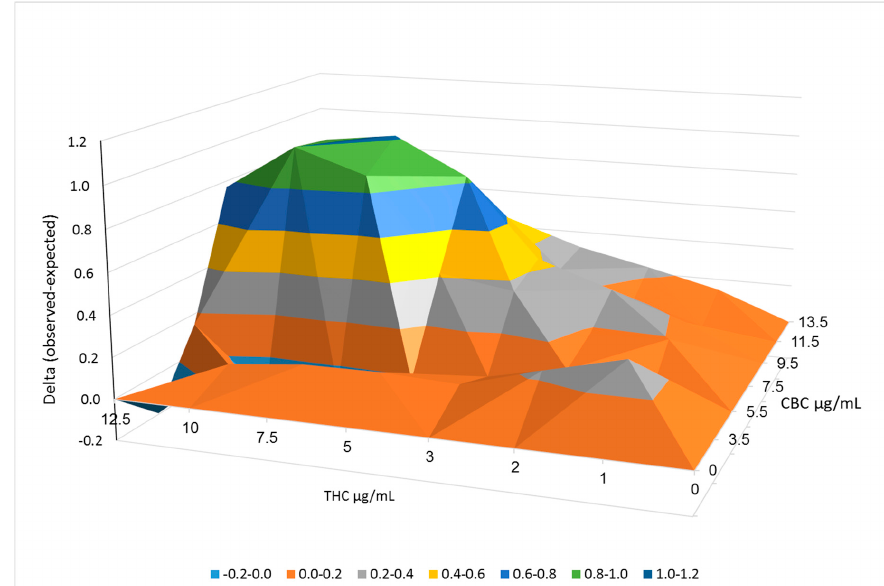
Figure 1. ( a ) Flash chromatography profile of C. sativa IGB strain crude extract. Fractions were collected and designated F4-F8. ( b ) Cell viability of T24 cells treated with different fractions of C. sativa IGB strain extract and fractions. Cell viability was determined by XTT assay as a function of live cell number. Cells were treated with the crude extract and fractions F4, F5, F6, F7 and F8 at a concentration of 30 µg/mL for 48 h. Mitomycin-C (MMC, 8 µg/mL) served as a positive control. Methanol (control) treatment served as a solvent (vehicle) control. Error bars indicate ± SE ( n = 3). Levels with different letters are significantly different from all combinations of pairs by Tukey–Kramer honest significant difference (HSD; P ≤ 0.05). ( c – g ) Dose-effect curves of the crude extract, fractions F4, F5, F6, F7 and CBC + THC on the viability of the T24 cell line. ( h ) Dose-effect curves of crude extract of CBC + THC on the viability of HTB-9 cell line. Data points were connected by non-linear regression lines of the sigmoidal dose-response relation. GraphPad Prism was used to produce the dose-response curve and IC50 doses.